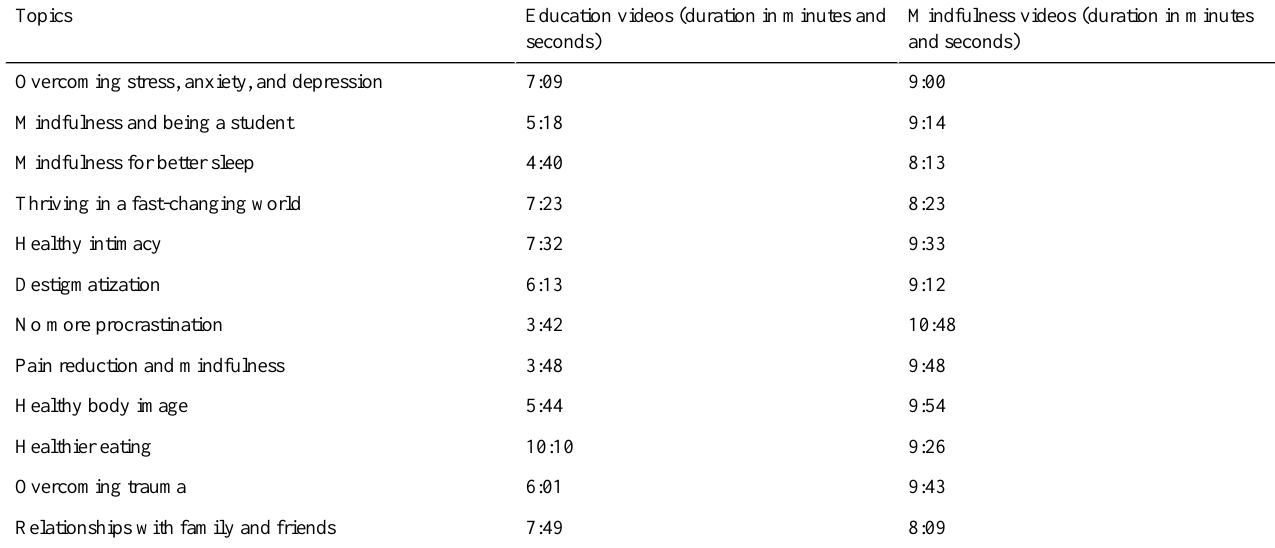
Table 1. Topics and duration of modules.